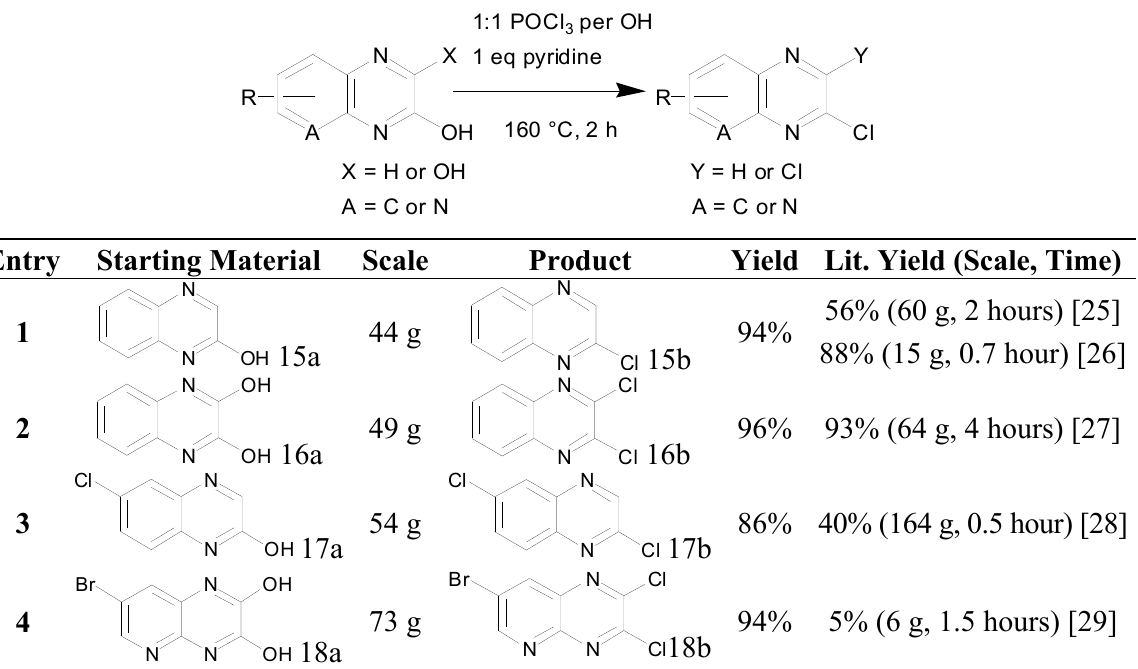
Table 3. Chlorination of hydroxyl benzopyrazions and pyridopyrazine (0.3 mole